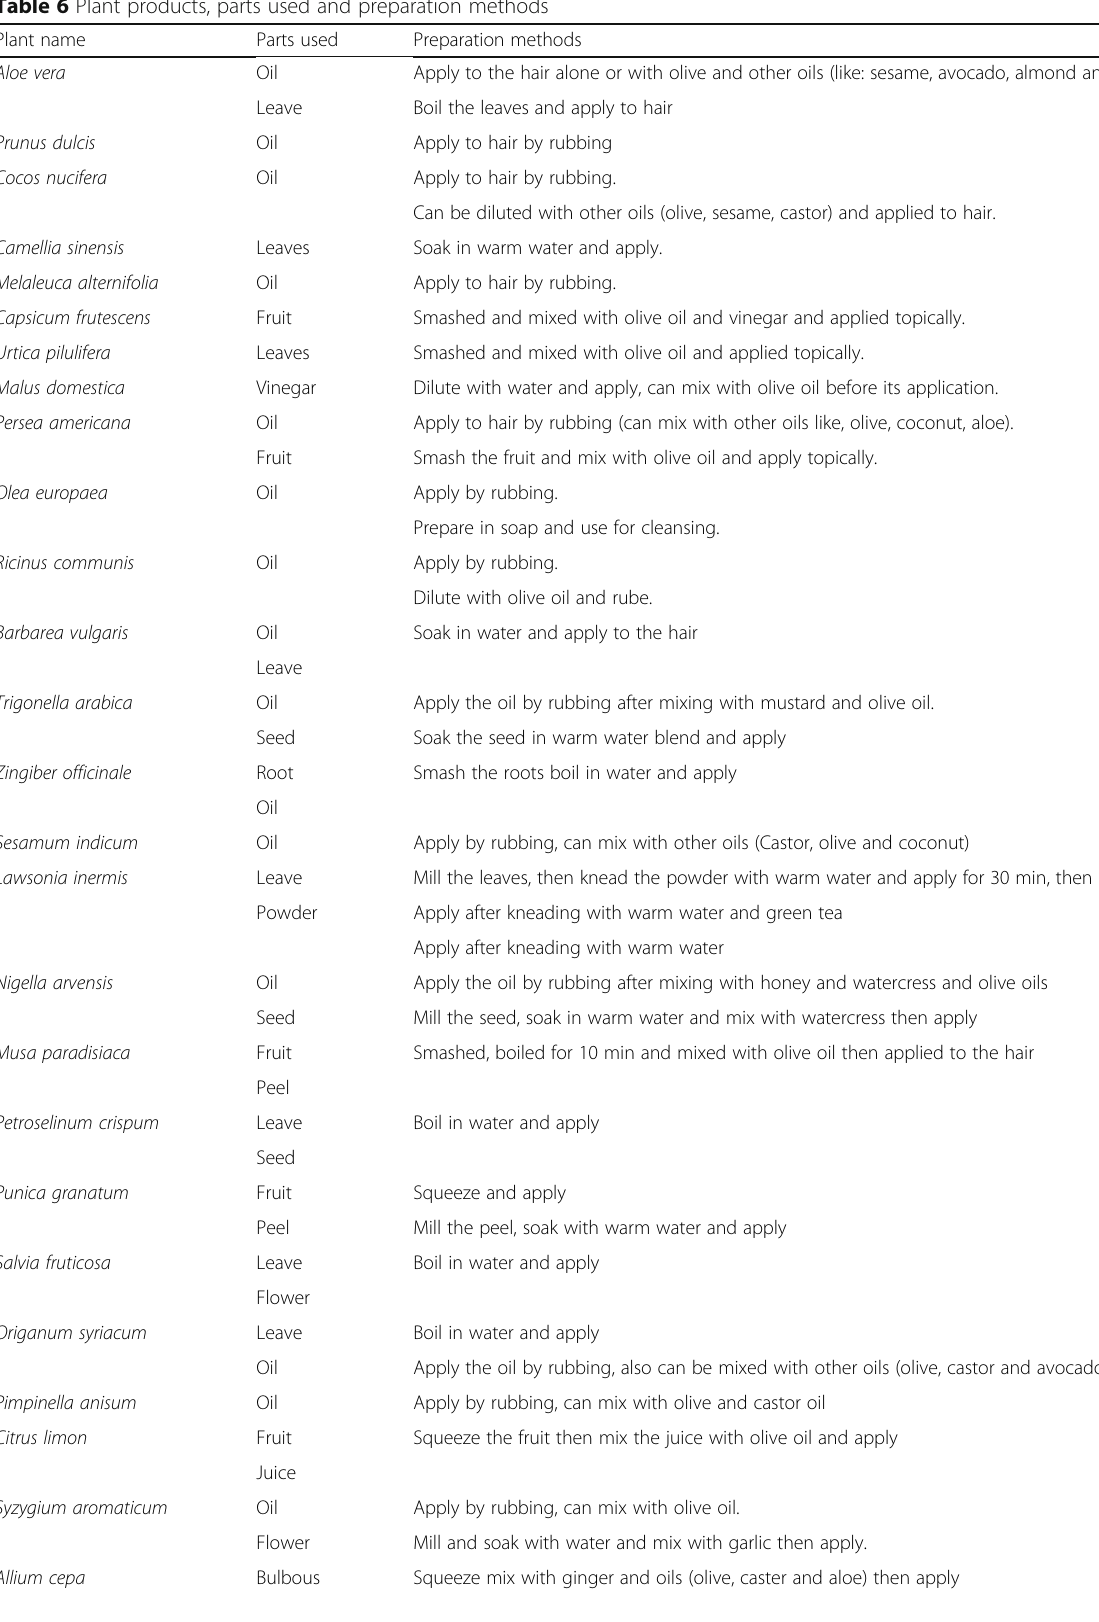
Table 6 Plant products, parts used and preparation